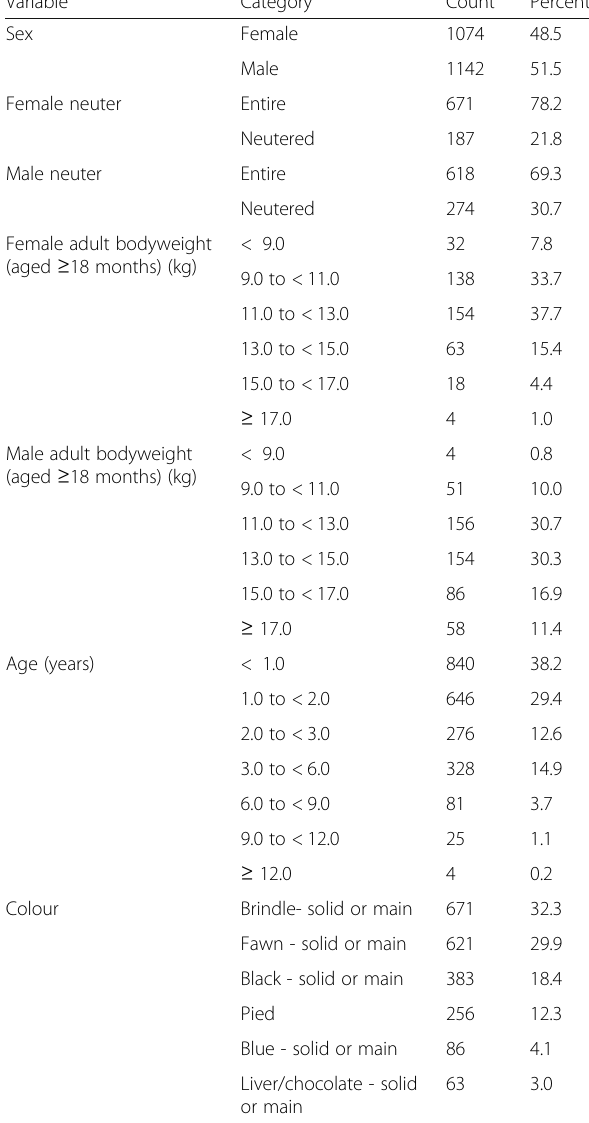
Table 1 Demography of French Bulldogs under